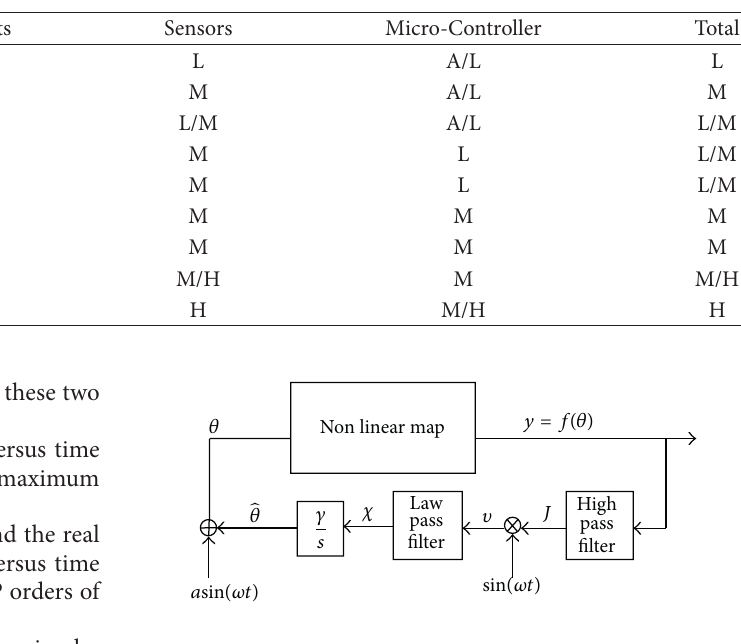
Figure 5: Extremum seeking algorithm